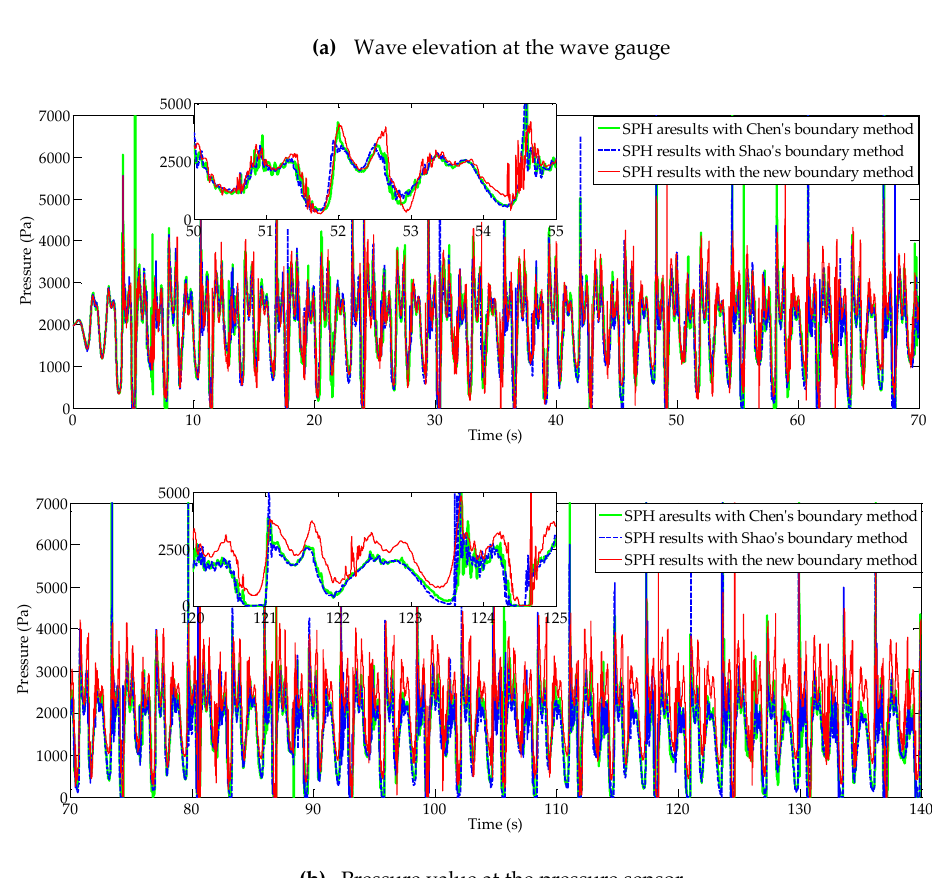
Figure 19. Numerical results obtained by SPH simulations: ( a ) Wave elevation at the wave gauge; ( b ) Pressure value at the pressure sensor.